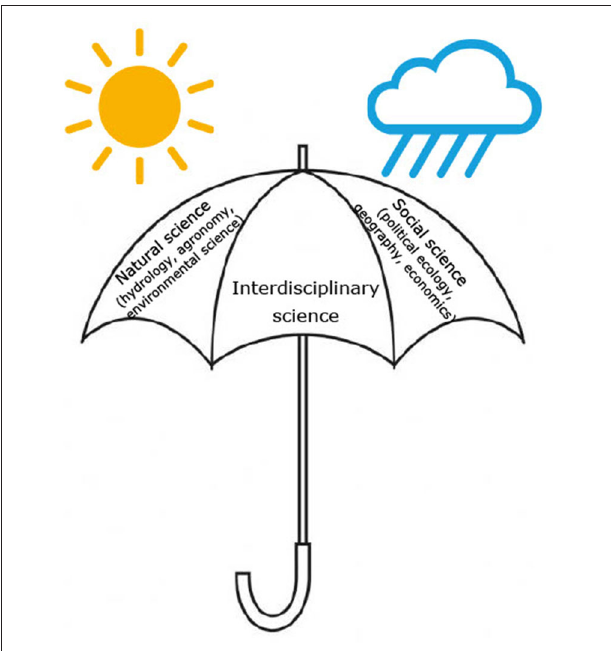
FIGURE 1 | Advocating conceptual and methodological pluralism, under one